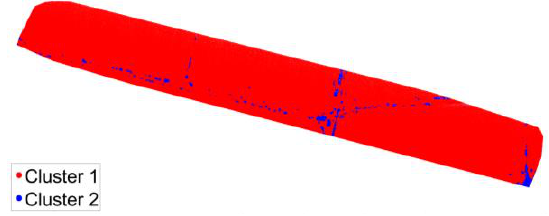
Figure 8. K-means clustering using Euclidean metric; results obtained for Block 3